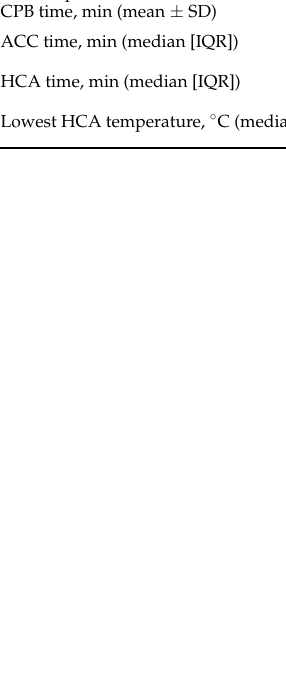
Table 6. Outcomes in patients with